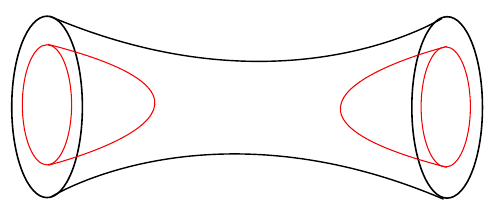
Figure 11 . A depiction of the factorised correlator h W ( C 1 ) ih W ( C 2 ) i with loops residing on oppo- site boundaries. The disk slices are three spheres and each loop is a circle sitting on one of the two asymptotic S 3 ’s. This con(cid:12)guration scales as O ( N 2